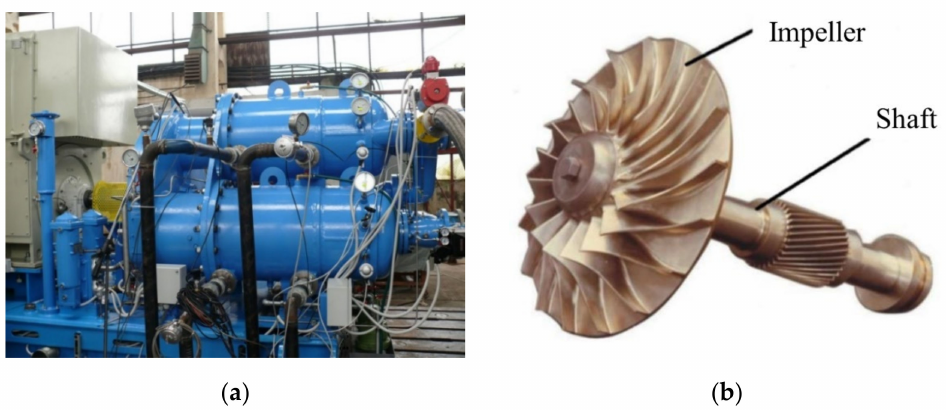
Figure 1. Representative images of ( a ) COMOTI CCAE 9-125 centrifugal compressor and ( b ) reference metallic impeller taken as input.